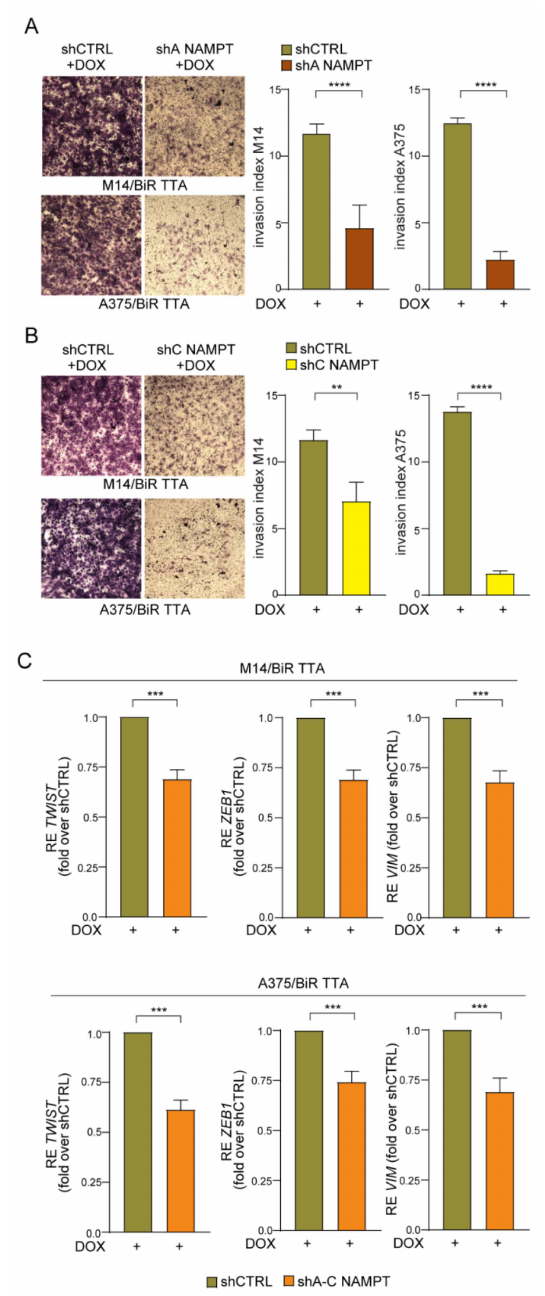
Figure 7. NAMPT silencing reverts the aggressiveness of / BiR cells. ( A , B ) Representative images ( × 10 magnification) of invasion assay in matrigel of M14 / BiR TTA and A375 / BiR TTA cell lines inducible shA NAMPT ( A ) and shC NAMPT ( B ) in comparison with shCTRL cells treated with DOX (1 µ g / mL) for 24 h before performing assay. On the right histograms represent cumulative data of invasion assays (at least 5 independent experiments). Invasion index was calculated as: number of cells penetrated in the presence of the chemoattractant / number of cells penetrated without chemoattractant. Mann-Whitney test. ( C ) qRT-PCR analysis showing expression of mesenchymal markers including TWIST , ZEB1 and VIM in M14 / BiR TTA and A375 / BiR TTA cell lines inducible shNAMPT vs. shCTRL cells treated with DOX (1 µ g / mL) for 24 h. Results show the reduction of expression of the genes in NAMPT silenced cells (sh A – C ) compared with shCTRL (results are represented as fold-over shCTRL of at least 8 independent experiments, Wilcoxon test). Data in the Figure are presented as the mean ± SEM. Significance was represented as: ** p ≤ 0.01, *** p ≤ 0.001 and **** p ≤